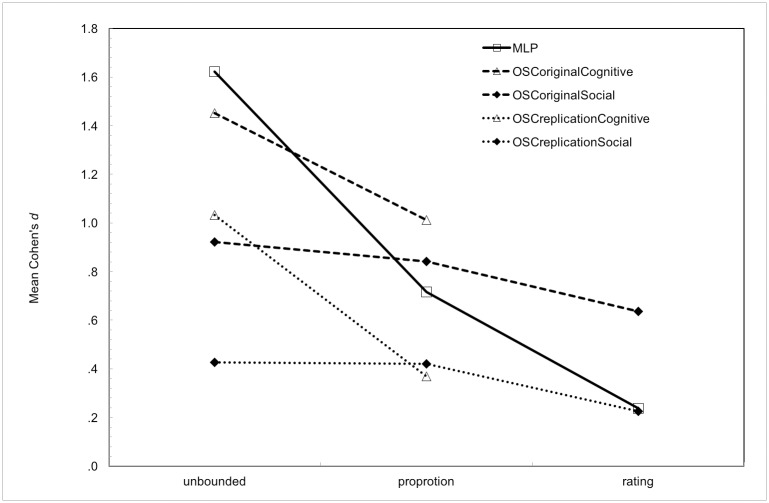
Cohen’s d as function of measure type for OSC cognitive, OSC social and MLP studies.